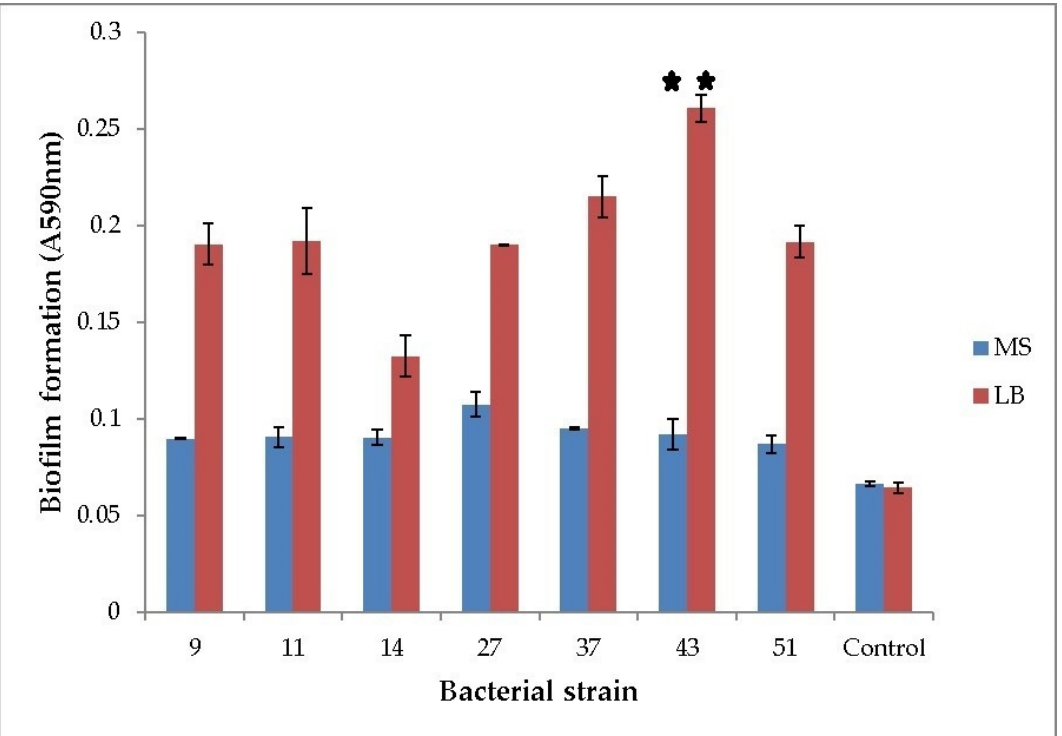
Figure 1. Biofilm formation of phenol-degrading bacteria. Seven bacterial strains were grown at 25 °C in LB and phenol-supplemented MS medium. Y -axis represents optical density of biofilm (OD 590nm ). Numbers on the x -axis represent bacterial strains: 9— K. oxytoca , 11— Lelliottia , 14— K. oxytoca , 27— S. marcescens , 37— H. alvei , 43— H. paralvei , 51— S. nematodiphila . Control is sterile medium (LB or MS with phenol). Data represent the mean ± SE ( n = 3). Mean with ** is significantly di ff erent and signifies the best biofilm formation. One-sample t -test, 6 df, p <